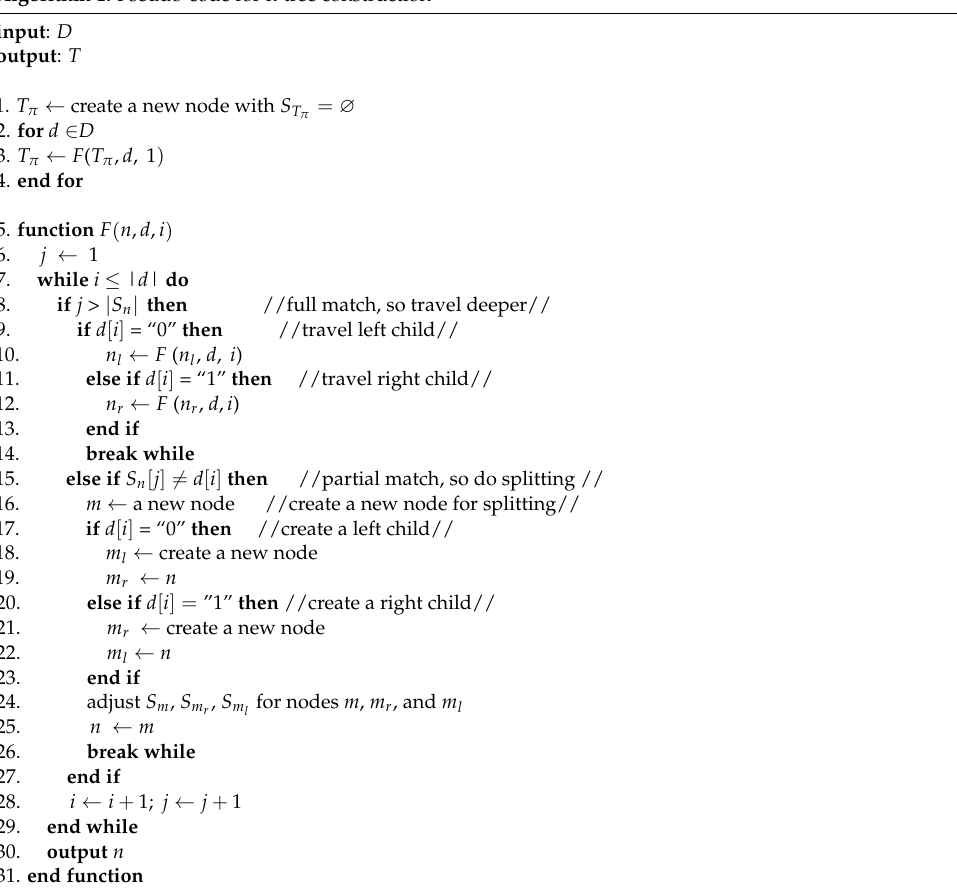
Algorithm 1. Pseudo-code for k-tree